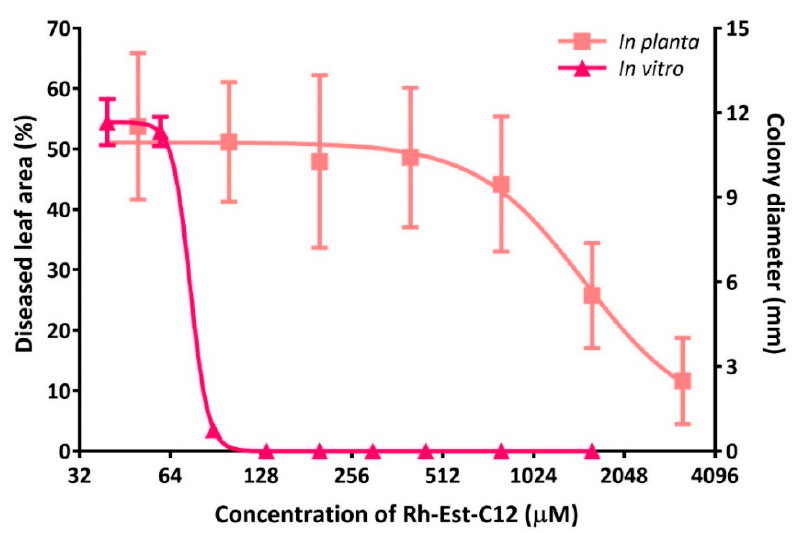
Figure 2. Comparison of in planta and in vitro dose-response curves of Rh-Est-C12 on the wheat- Zymoseptoria tritici pathosystem. Wheat cultivar Alixan and Z. tritici strain T02596 were used. The in planta activity of the compound was assessed by measuring the percentage of chlorosis and necrosis on the third leaves of each plant at 21 days after inoculation. Bars stand for standard deviations.